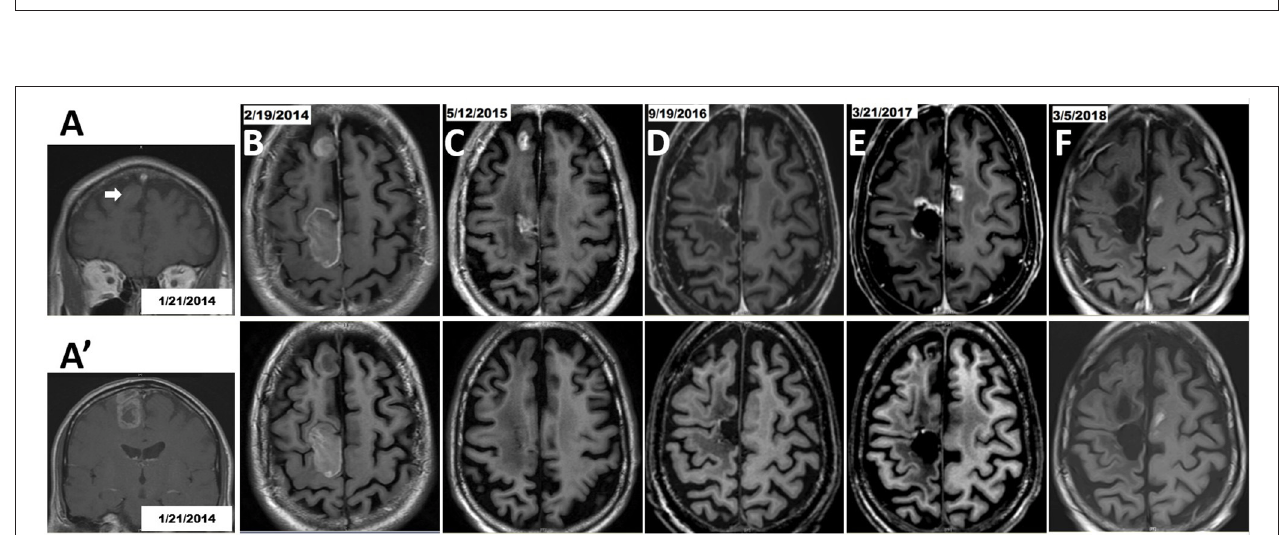
FIGURE 4 | Therapy with TBI in combination with Gamma Knife stereotactic radiosurgery after the second GBM progression in patient number 5. Initial craniotomy was on 1/25/2014, but axial section images were not available in the pre-operative MRI. (A) Coronal view of anterior right frontal lesion (arrow). (A’) Coronal view of posterior right frontal lesion. (B) Post-operative MRI. Tumor in the posterior right frontal lobe was removed while the mass at the right anterior frontal lobe was untouched. (C) MRI on 5/12/2015 showed that tumor in the right anterior frontal lobe progressed as a non-targeted lesion while on EF-14 clinical trial, and this lesion was treated with Gamma Knife on May 20, 2015. The patient had been treated with TBI therapy for 1 year and then it stopped as scheduled. (D) MRI on 9/19/2016 suggested tumor progression around the surgical cavity and he had a 2nd craniotomy on 9/25/2016. But pathology demonstrated no active tumor. This was not considered as progression of disease. (E) The 2nd disease progression was diagnosed based on MRI (3/21/2017) because of an appearance of a new lesion in the left hemisphere which was treated with Gamma Knife on 4/5/2017. The TBI regimen was restarted. (F) The progressive disease was well-controlled based on the latest MRI on 3/5/2018; lesions were treated with Gamma Knife followed by TBI regimen plus TTFields. Brain MRI T1 with contrast shown in upper row and brain MRI T1 without contrast shown in the corresponding lower row.